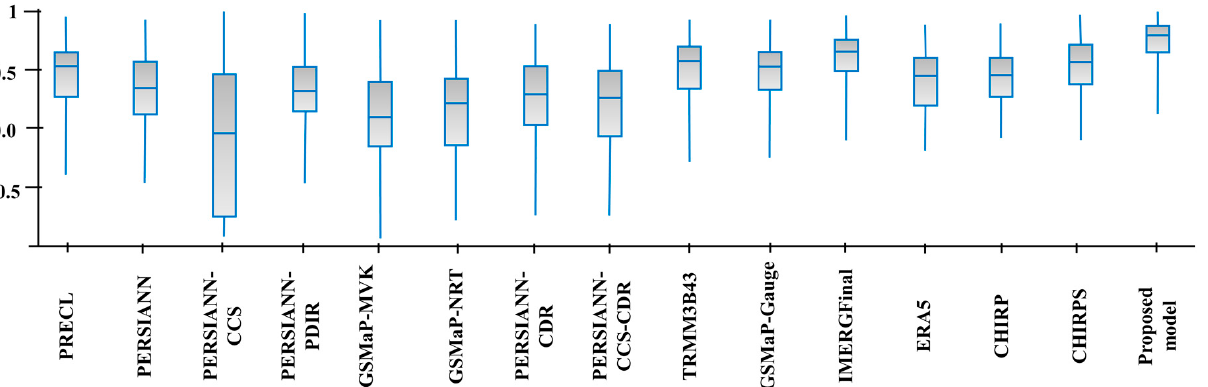
Table 4. Results of accuracy evaluation of different precipitation products based on point- to-pixel strategy in geographical location of validation stations.